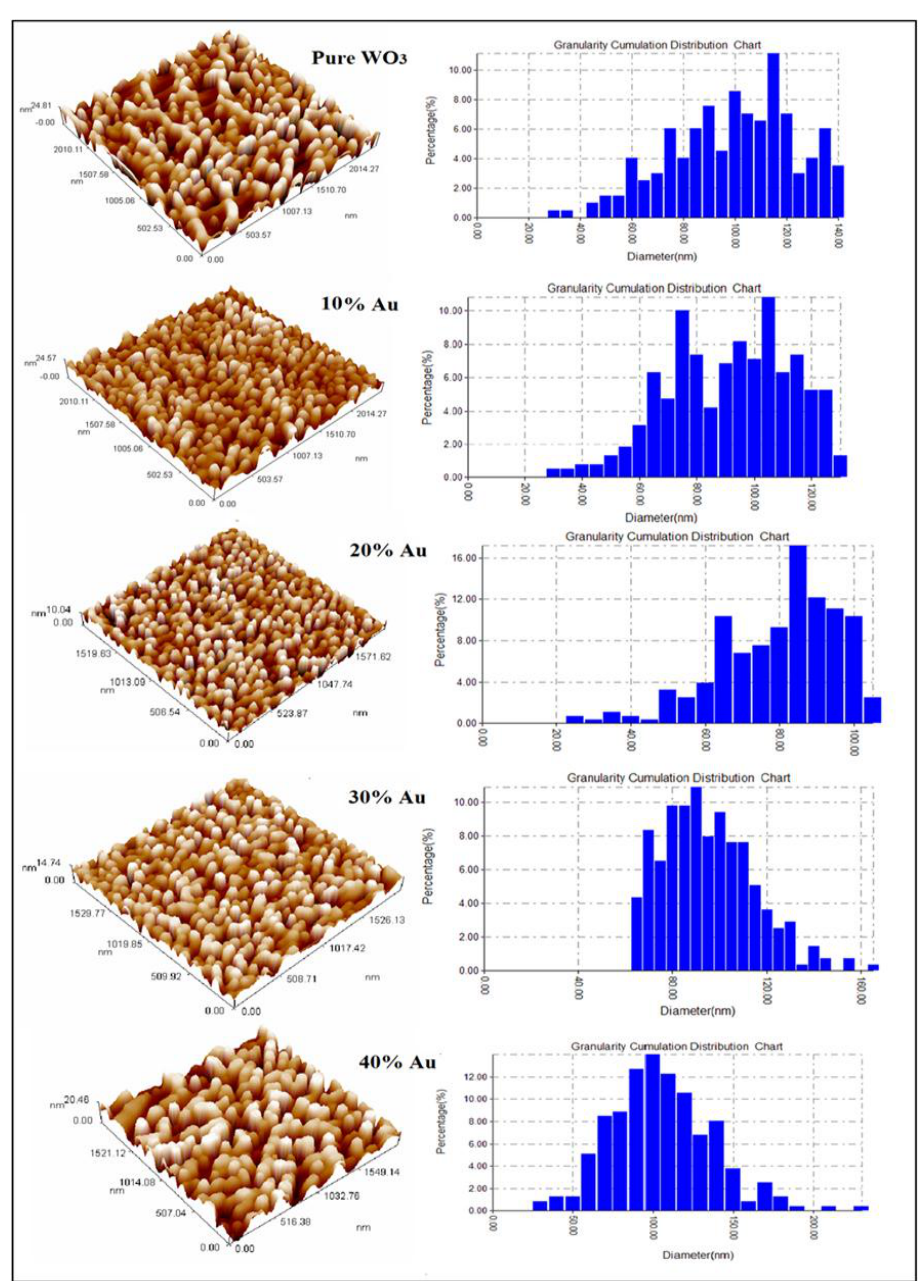
Fig. 4: AFM image and size distribution for WO films with annealing temperature at T